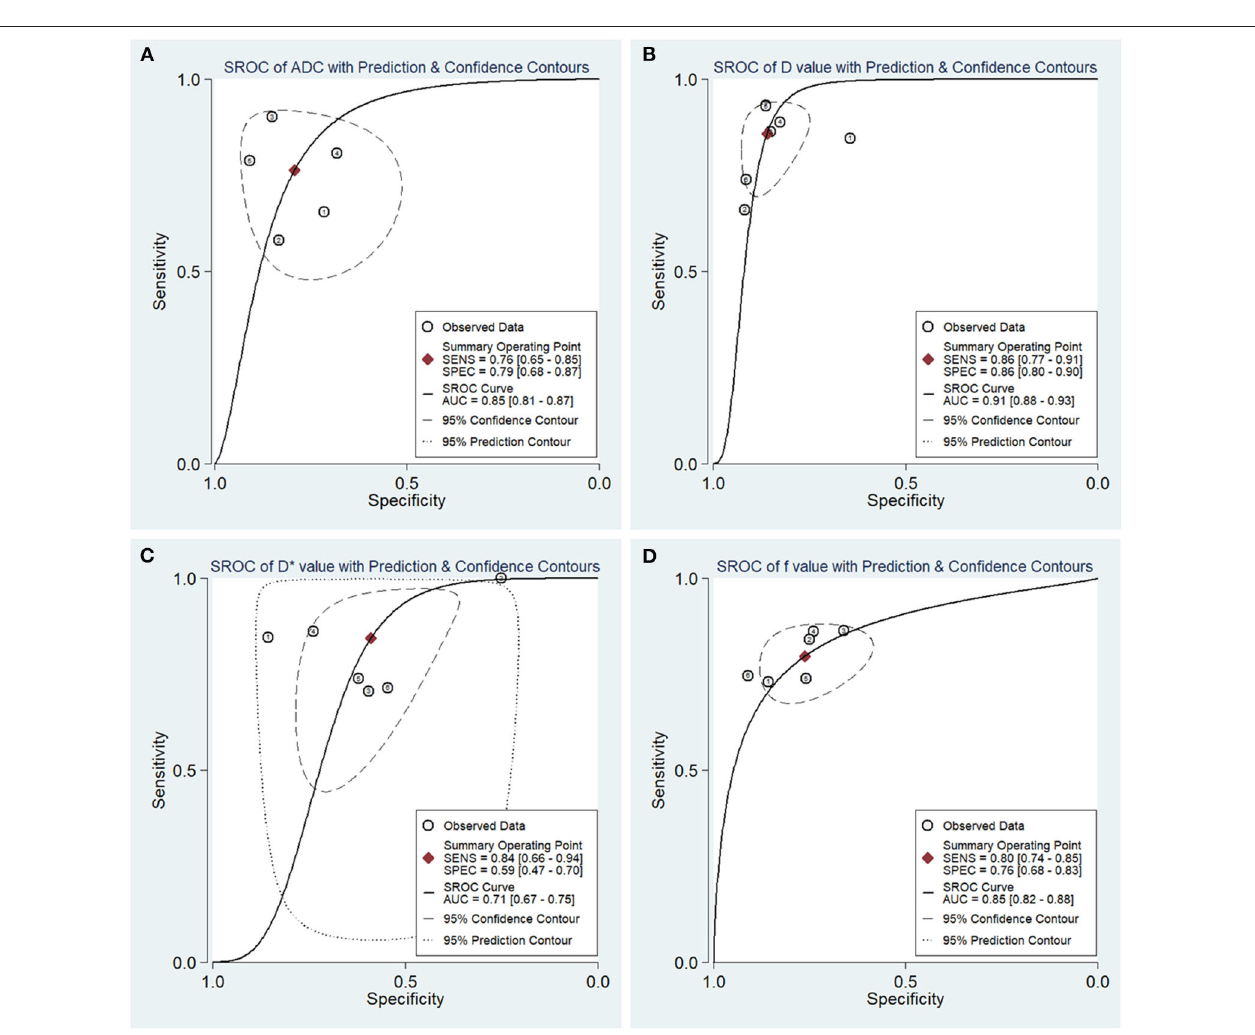
FIGURE 7 | Summary receiver operating characteristic (SROC) curves of (A) the apparent diffusion coefficient (ADC), (B) tissue diffusivity (D), (C) pseudodiffusivity (D*), and (D) the perfusion fraction (f) in the diagnosis of breast lesions. D had the largest area under the curve (AUC) among the four parameters, followed by the ADC, f and D*